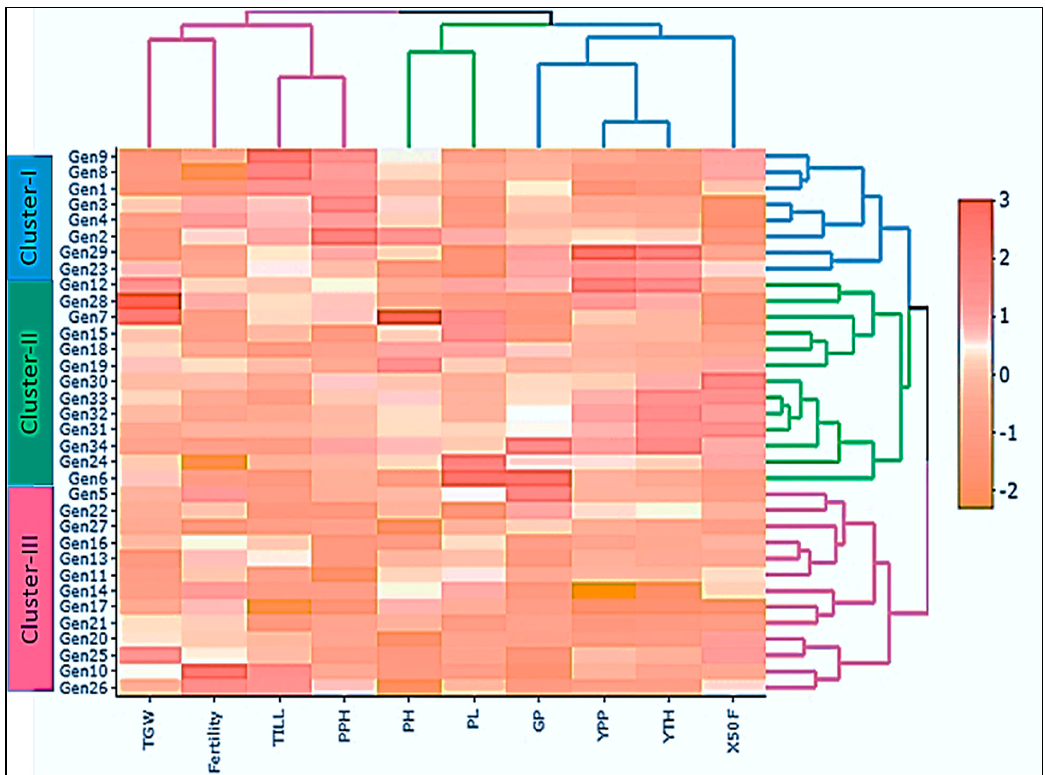
Figure 7. The heatmap displays the clustering pattern of 34 rice genotypes with 10 quantitative characters. Each column indicates a character, whereas each row represents a genotype. The various colours and intensities ( − 2 to 3) were adjusted based on the genotype–characters relationship. The orange colour represents a lower value, the white colour for mid value, and the dark red indicates a higher value.